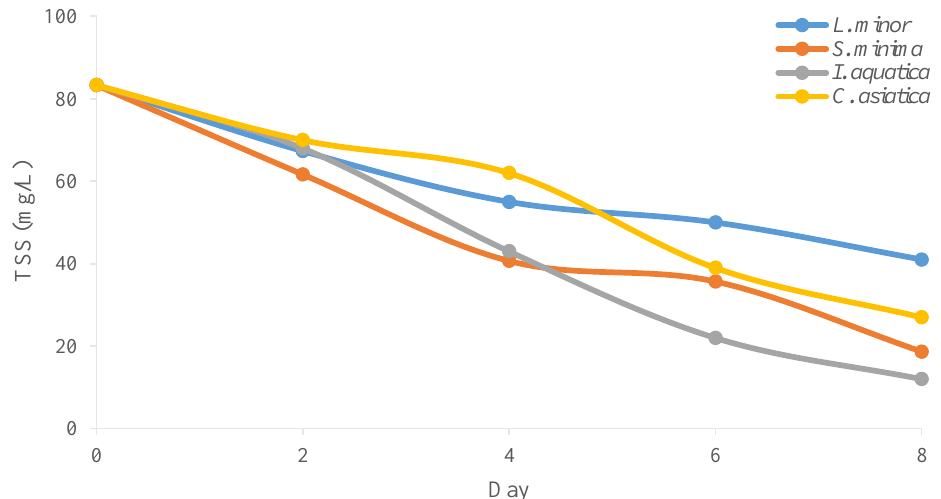
Figure 3. Graph of the average of TSS reading by the phytoremediation using Lemna minor , Salvinia minima , Ipomoea aquatica and Centella asiatica .